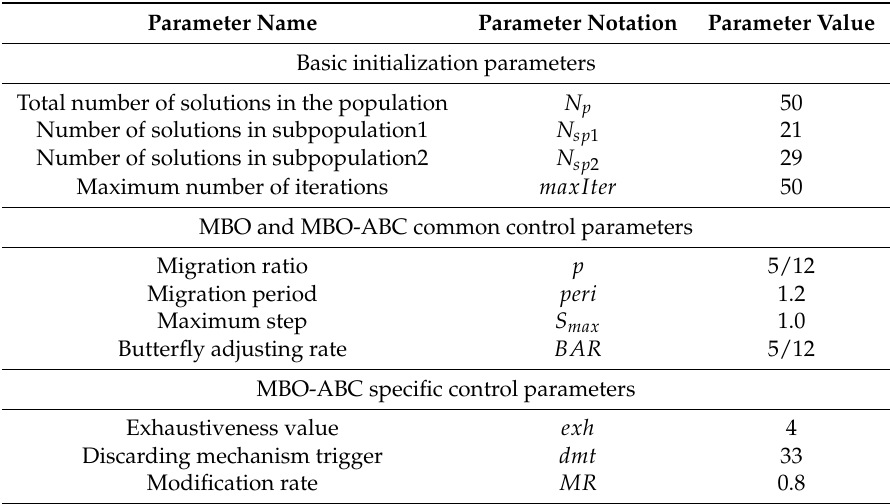
Table 2. MBO-ABC and MBO parameters’